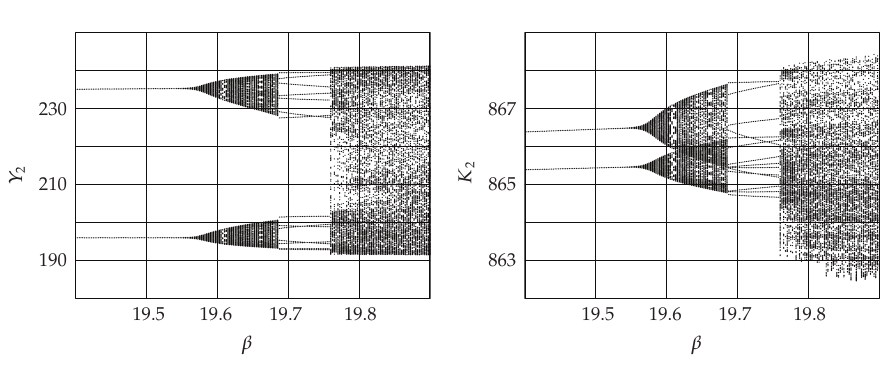
Figure 7: Details of bifurcation diagrams for α (cid:9) 1 . 5 .